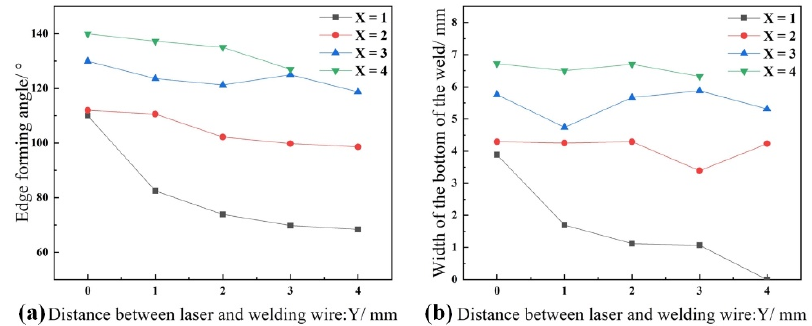
Figure 6. Different distance parameters with ( a ) weld edge forming angle ( b ) weld bottom width.